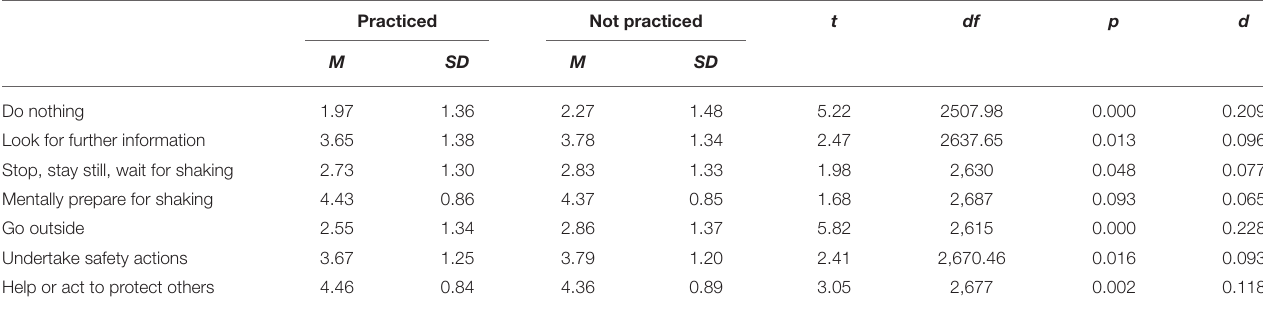
TABLE 4 | Results of independent samples t -tests comparing mean intentions scores for a range of actions between those who have and have not practiced responding to an earthquake drill. Practiced Not practiced t df p d M SD M